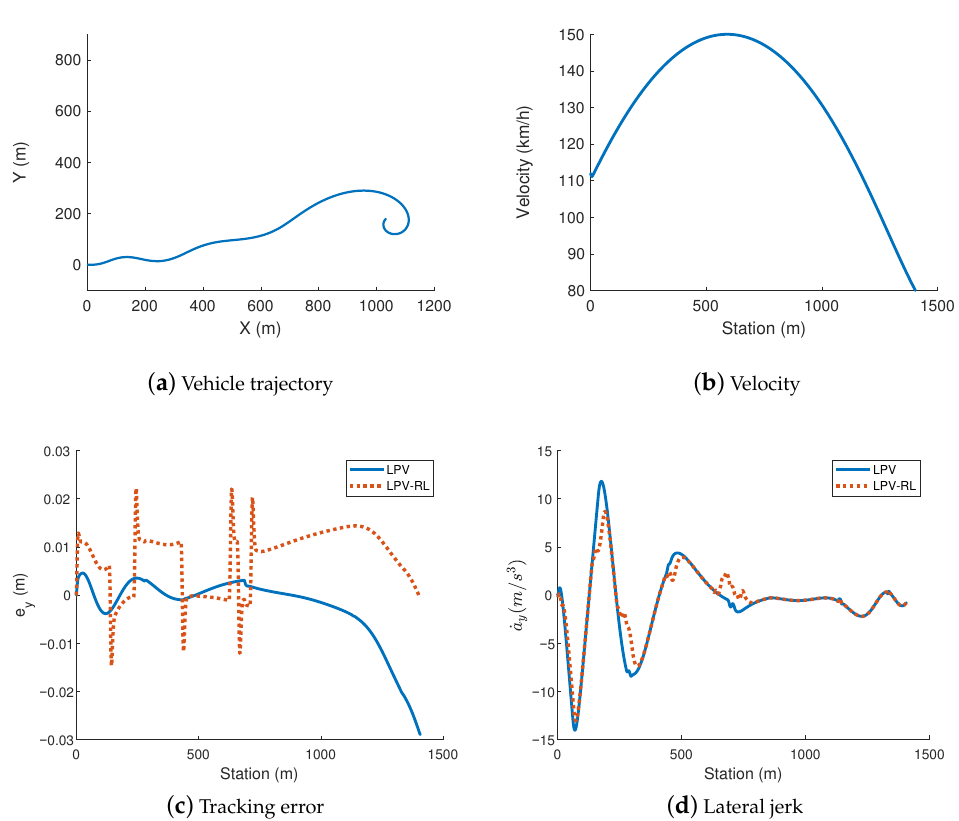
Figure 4. Results of the simulation